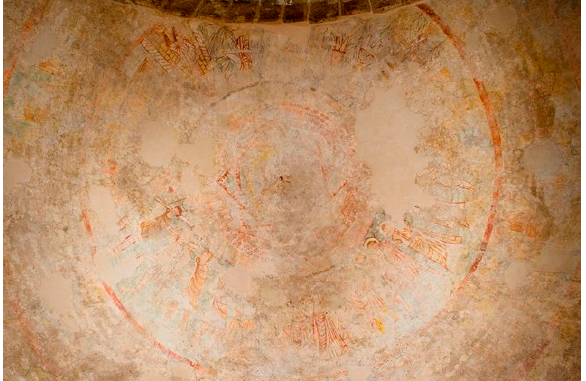
Figure 27. Santa Maria de Terrassa, wall paintings. © author.